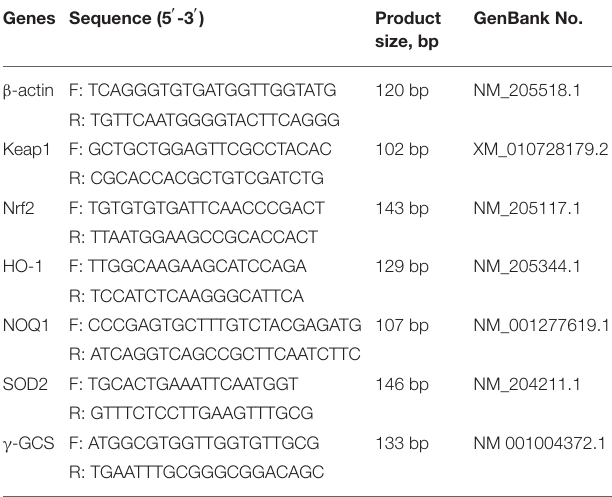
TABLE 2 | Information on serum and liver biochemical indexes and the kits used. Items Abbreviation Kit No.